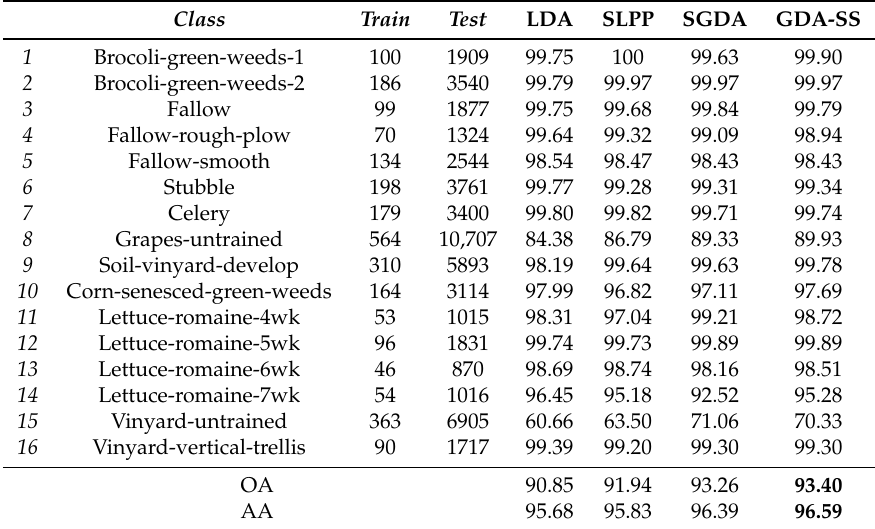
Table 1. SVM class-specific accuracy (%), overall accuracy (OA) and average accuracy (AA) of different techniques for the Salinas